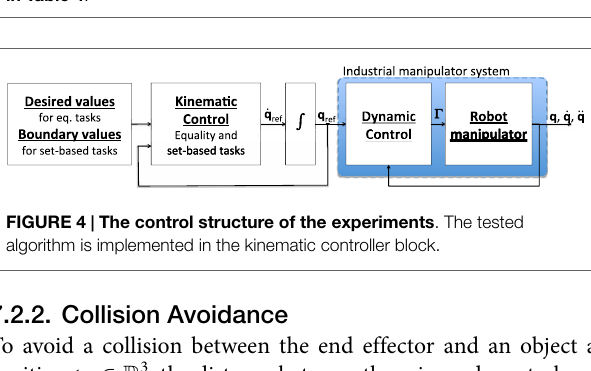
FIGURE 3 | Coordinate frames corresponding to the D–H parameters in Table 4 .